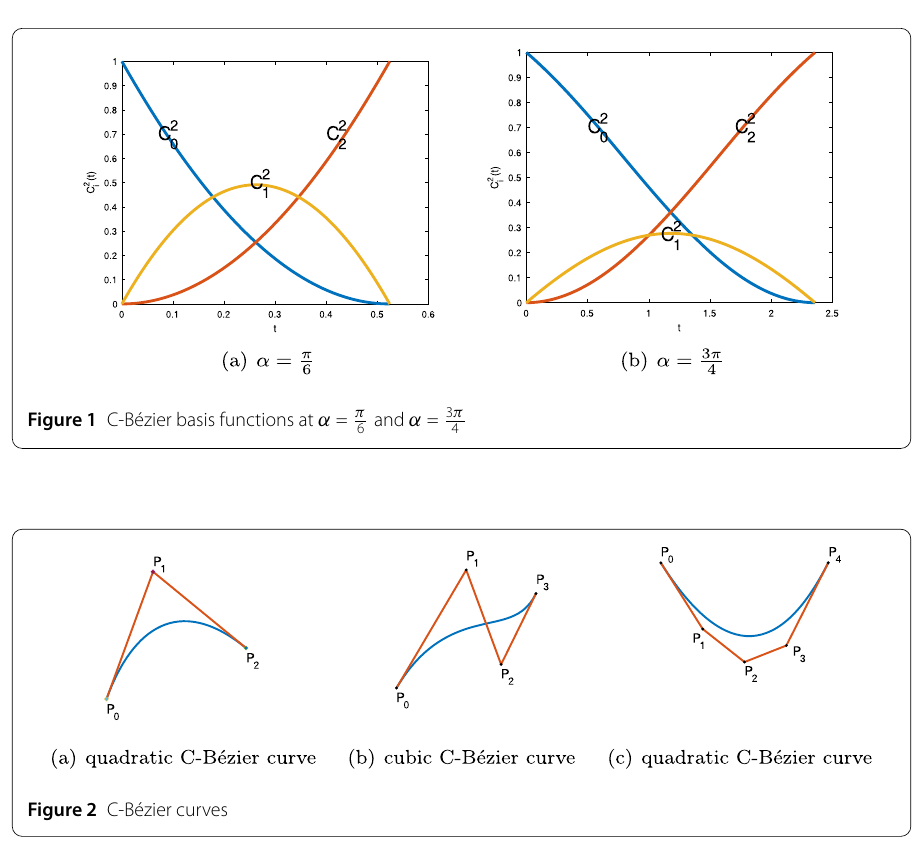
Figure 2 C-Bézier